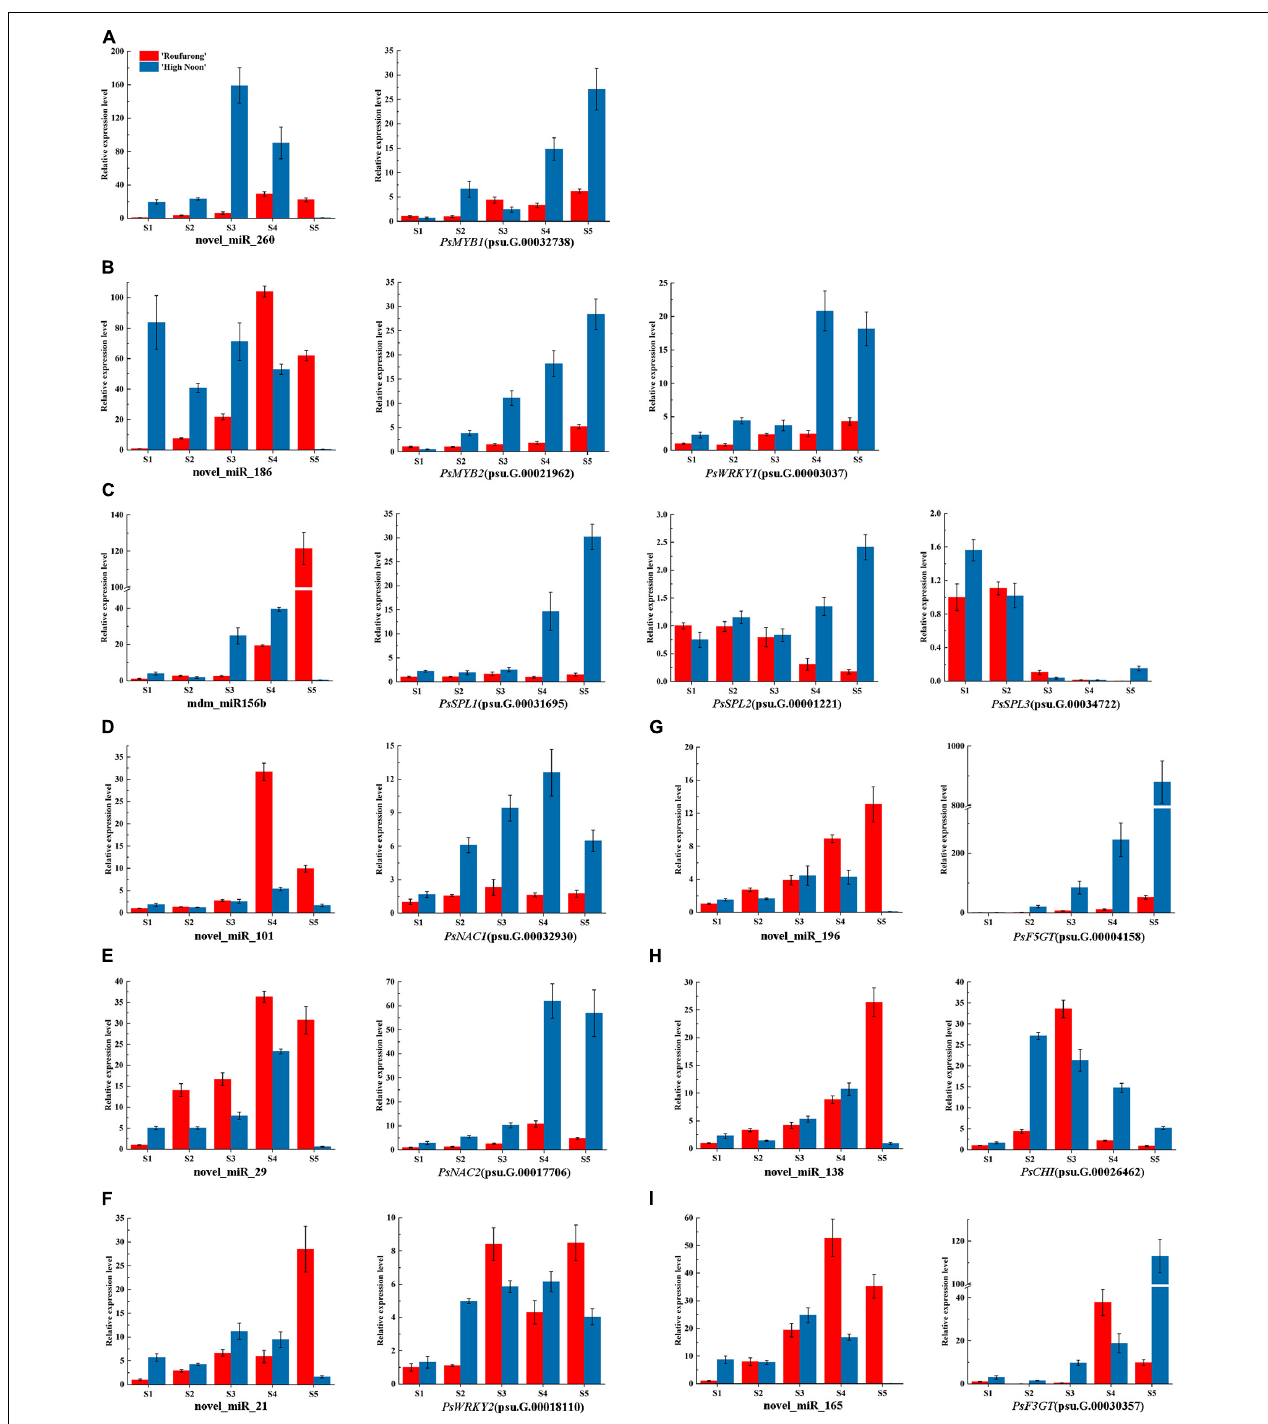
FIGURE 3 | Dynamic expression patterns of candidate miRNAs and their corresponding target genes at five blooming stages in “High Noon” and “Roufurong.” (A) novel_miR_260 and its target gene PsMYB1 (psu.G.00032738). (B) novel_miR_186 and its target genes PsMYB2 (psu.G.00021962) and PsWRKY1 (psu.G.00003037). (C) mdm_miR156b and its target genes PsSPL1 (psu.G.00031695), PsSPL2 (psu.G.00001221), and PsSPL3 (psu.G.00034722). (D) novel_miR_101 and its target gene PsNAC1 (psu.G.00032930). (E) novel_miR_29 and its target gene PsNAC2 (psu.G.00017706). (F) novel_miR_21 and its target gene PsWRKY2 (psu.G.00018110). (G) novel_miR_196 and its target gene PsF5GT (psu.G.00004158). (H) novel_miR_138 and its target gene PsCHI (psu.G.00026462). (I) novel_miR_165 and its target gene PsF3GT (psu.G.00030357). S1: Stage 1, unpigmented tight bud; S2: Stage 2, slightly pigmented soft bud; S3: Stage 3, initially opened flower; S4: Stage 4, half opened flower; S5: Stage 5, fully opened and pigmented flower with exposed